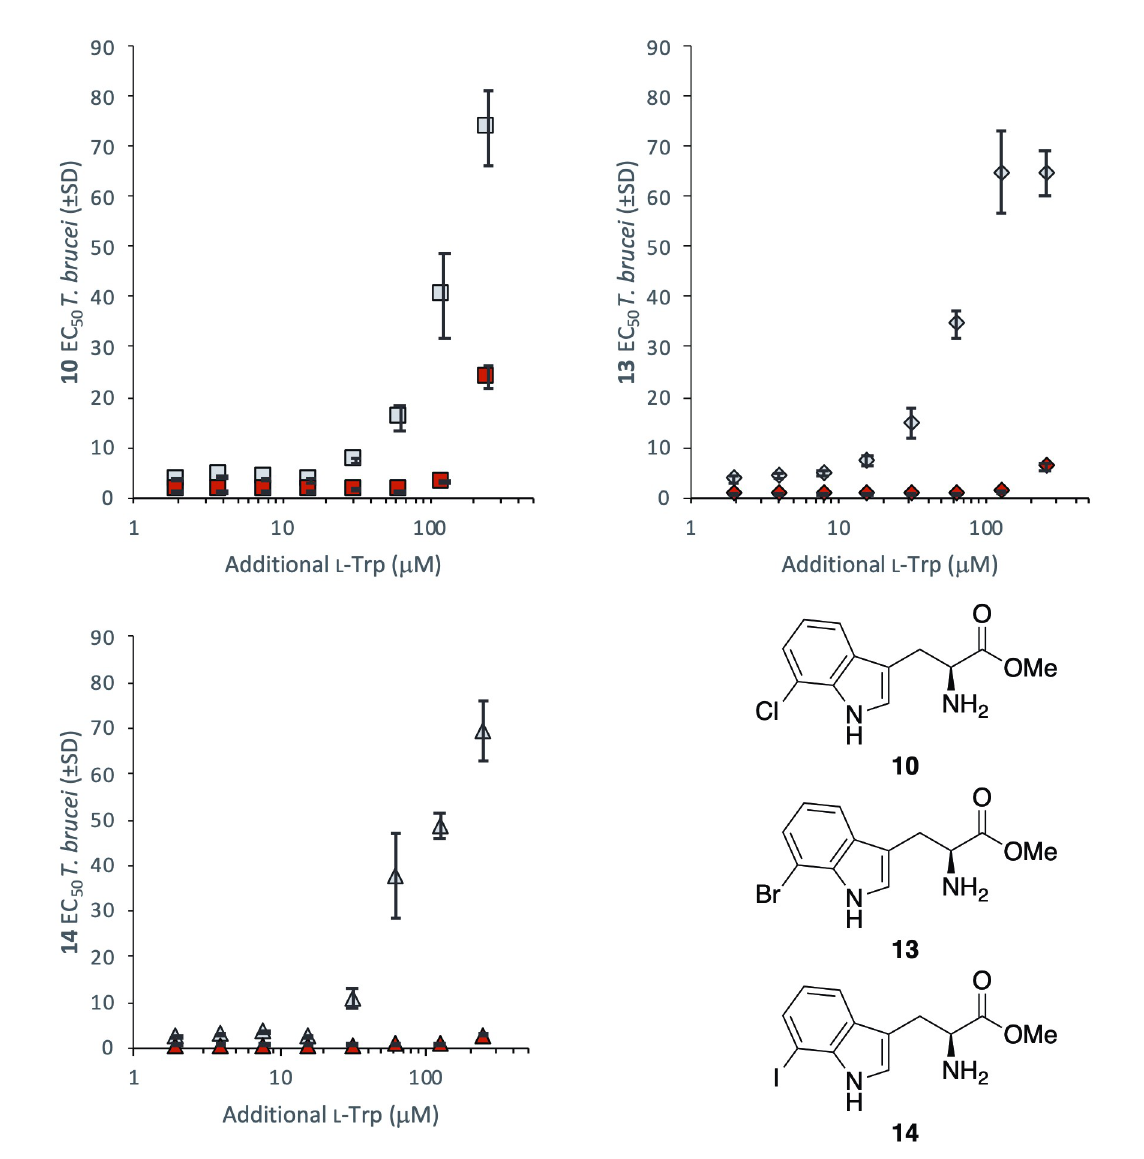
Fig 7. The effect of supplementary tryptophan ( μ M ± SD) added to media on the EC 50 values ( μ M ± SD) of substituted tryptophan methyl esters 10, 13 and 14 against T . brucei BSF (grey) and T . brucei PCF (red) parasites. SD determined from n = 3